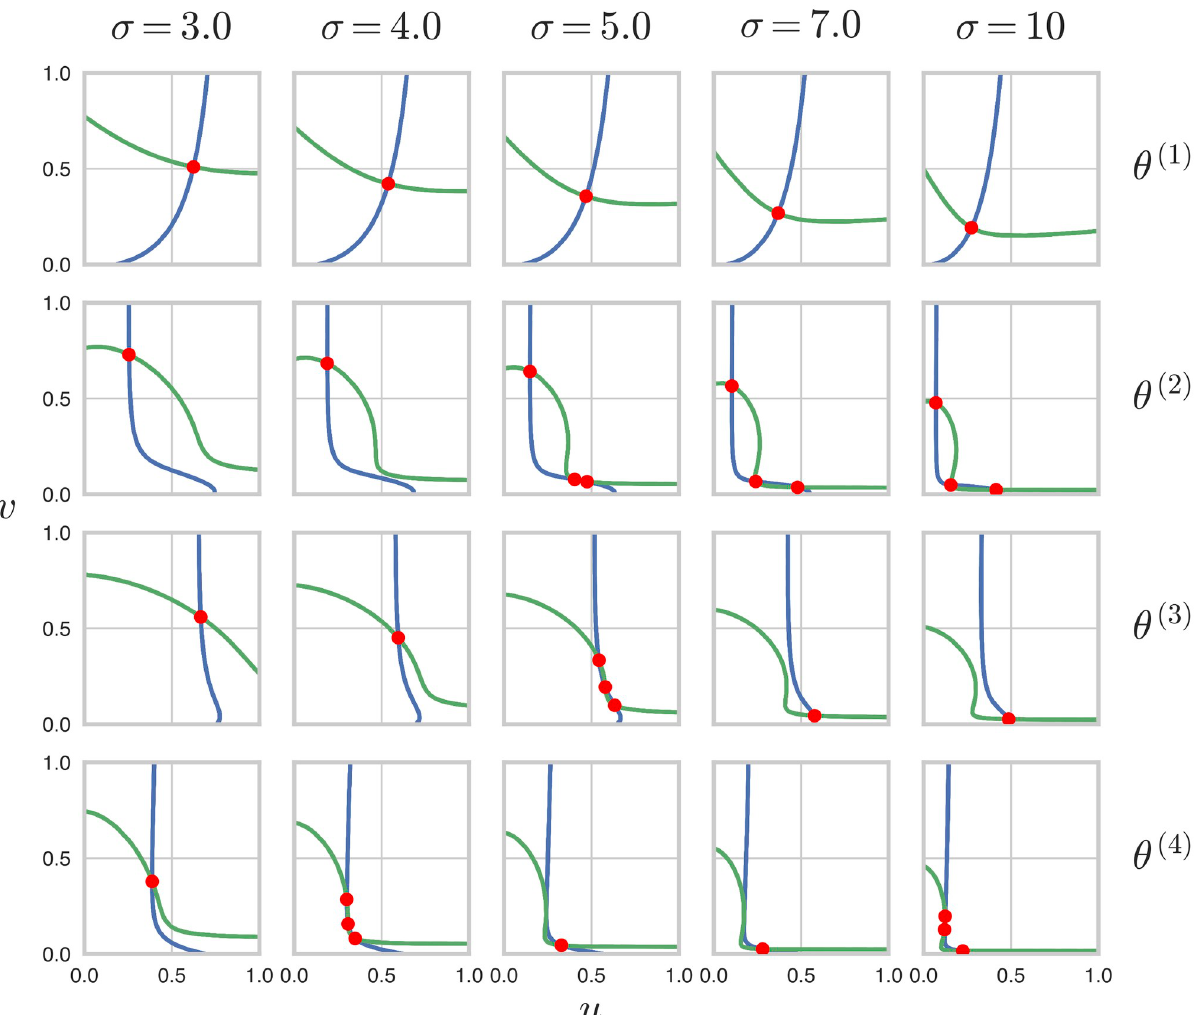
Fig 5. Parameter points move between monostability and bistability. Pseudo-nullcline plots for the steady-state equations, F 1 ( u , v ) = 0 (blue) and F 2 ( u , v ) = 0 (green), in Eq 10 are shown for the four parameter values given in the main text, at five values of σ , showing how steady-states (red dots) appear and disappear at the intersections of the pseudo-nullclines. The zero solution, u = v = 0 is isolated from the pseudo-nullclines in the real uv -plane and is not shown for